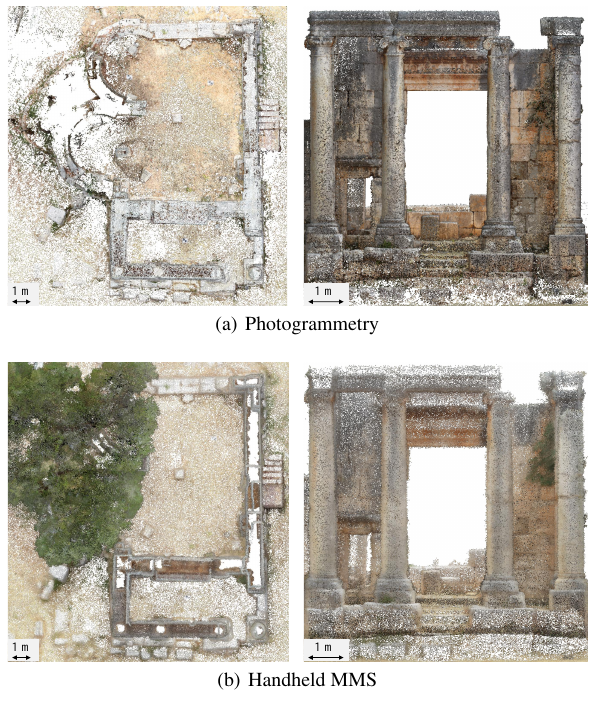
Figure 9. Top and frontal views of the 3D point clouds of the Bziza temple, obtained from the photogrammetric survey (a) and with the handheld MMS (b).